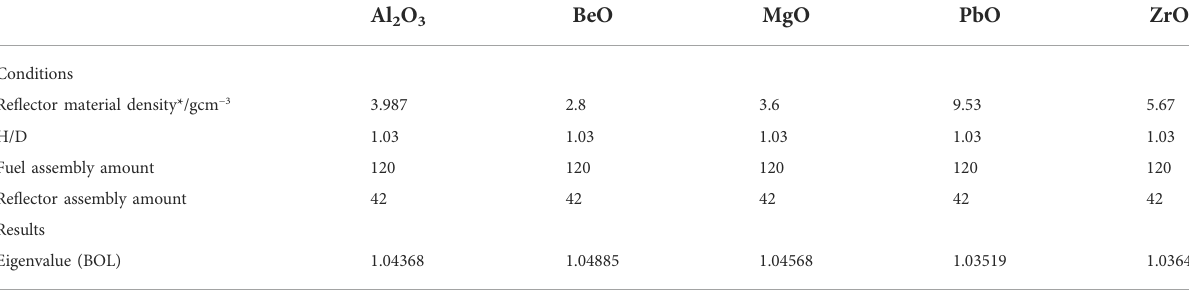
TABLE 4 Conditions and results of the re fl ector material analysis.